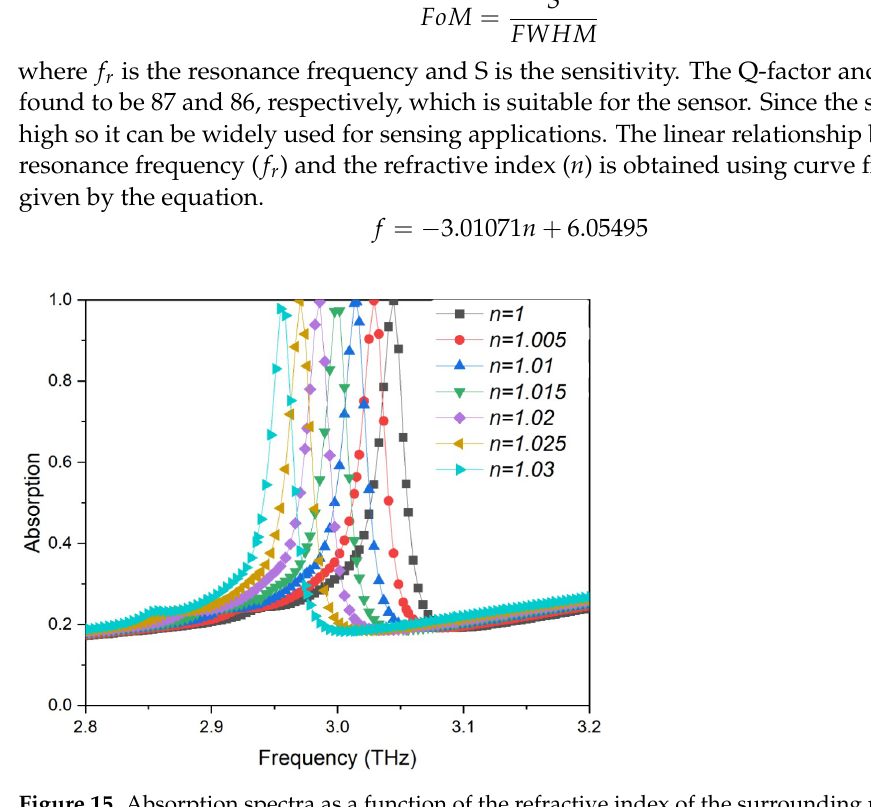
Figure 15. Absorption spectra as a function of the refractive index of the surrounding medium.